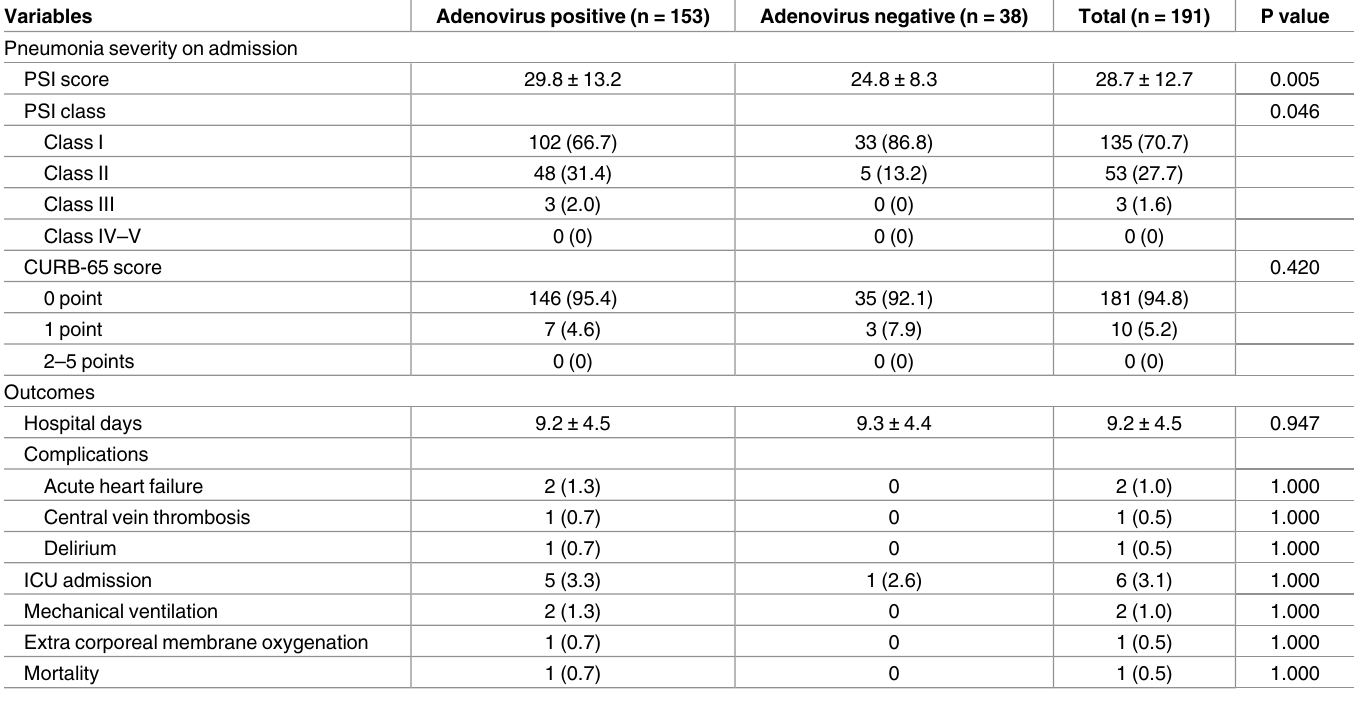
Table 4. Pneumonia severitiesand outcomes of 191 patients with community-acquired pneumonia in the